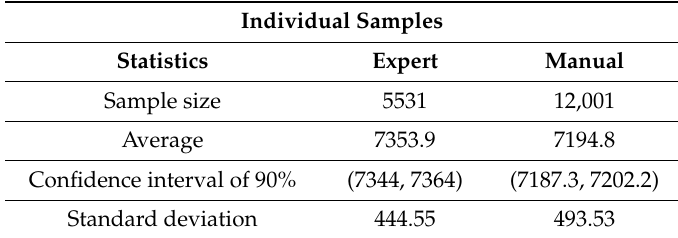
Table 8. Hypothesis test: manual operation vs. operation expert